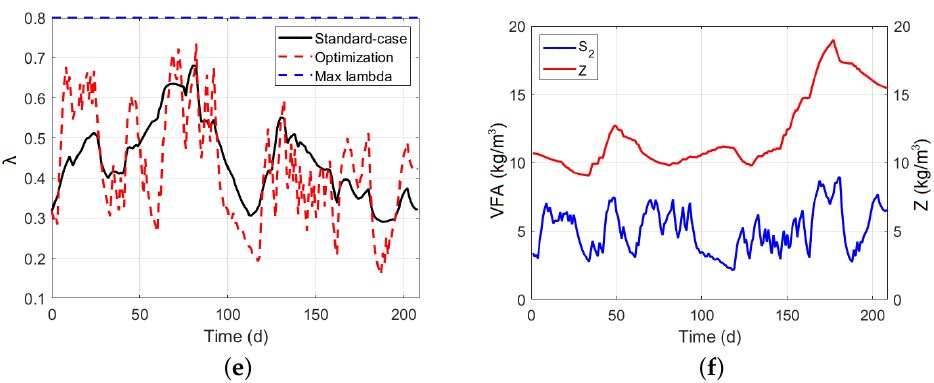
Figure 10. MPC controller with restrictions. ( a ) CH 4 evolution; ( b ) D values calculated by optimizer; ( c ) pH values; ( d ) VFA values; ( e ) λ over the process; ( f ) evolution of S 2 and Z.